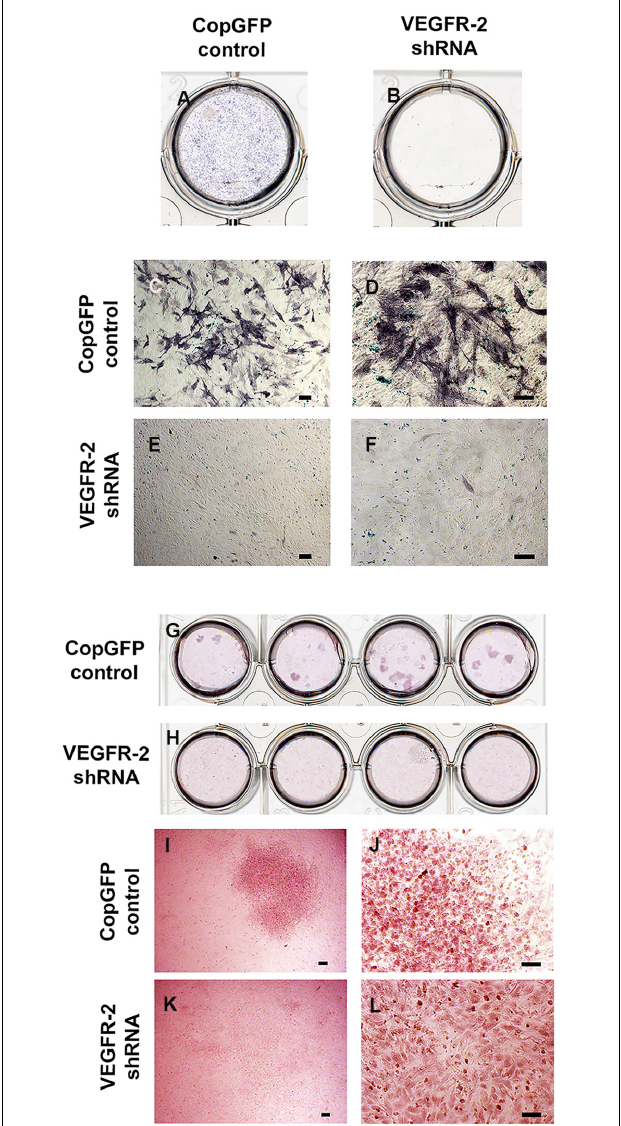
FIGURE 3 | Alkaline phosphatase and Alizarin Red S staining in CopGFP control and VEGFR-2 shRNA DPSCs after a culture in osteo-odontogenic BMP-2 media. Alkaline phosphatase staining demonstrated a dissimilar result between CopGFP control (A) and VEGFR-2 shRNA DPSCs (B) after osteo-odontogenic induction in BMP-2 media. Abundant positive alkaline phosphatase stained cells (in dark-bluish purple) were shown in CopGFP control DPSCs, suggesting DPSCs undergoing osteo-odontogenesis (C,D) . Few slightly positive stained for alkaline phosphatase staining were found in VEGFR-2 shRNA DPSCs (E,F) . Alizarin Red S staining demonstrated a different result between CopGFP control and VEGFR-2 shRNA DPSCs after osteo-odontogenic induction in BMP-2 media. Several Alizarin Red S positive mineralized nodules were detected in differentiated CopGFP control DPSCs (G) . There was absence of mineralized nodule found in differentiated VEGFR-2 shRNA DPSCs (H) . A representative figure reveals a low magnification of Alizarin Red S positive mineralized nodules in the CopGFP control (I) . The higher magnification of the nodule showed cuboidal-like cells, resembling osteo-odontoblast-like cells (J) . VEGFR-2 shRNA DPSCs did not show any mineralized nodule formation (K) but they were undifferentiated spindle-shaped (L) . Scale bars indicate 100 µ